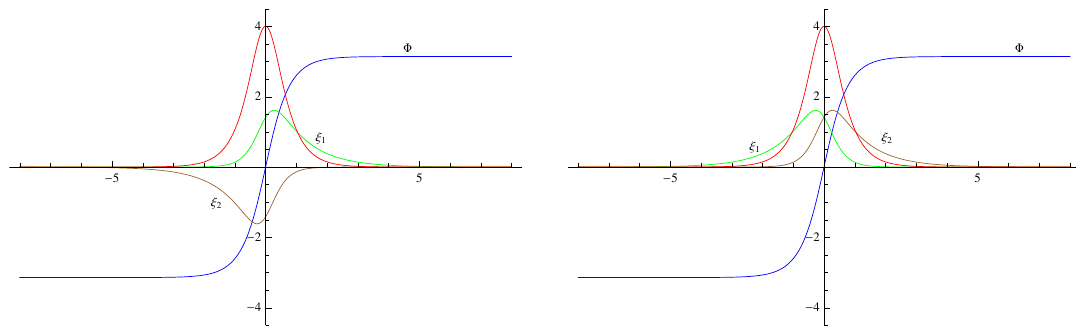
Figure 13 . The kink Φ (blue) and the Majorana zero-mode components ξ 1 (green) and ξ 2 (brown) −√ as functions of x . Left (Case I): for β = 1 , α 0 = − π , ζ 1 = − ζ 2 = 8 , κ = M = 1 , α 1 = π/ 2 . Right −√ 2 (Case II): for β = 1 , α 0 = − π , ζ 1 = ζ 2 = 8 , κ = M = 1 , α 1 = π . The red lines represent the 2 Majorana density ( ξ 2 + ξ 2 ) vs x , in each 1 2